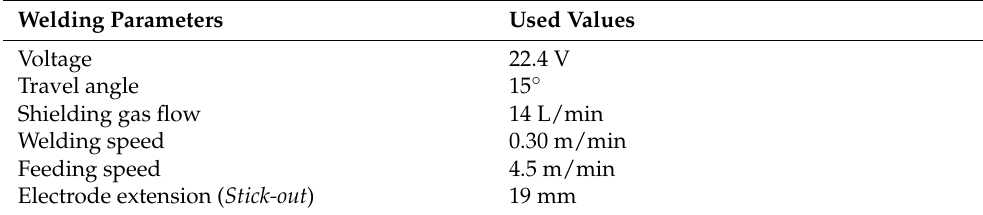
Table 5. Parameters used in welding of top joints.